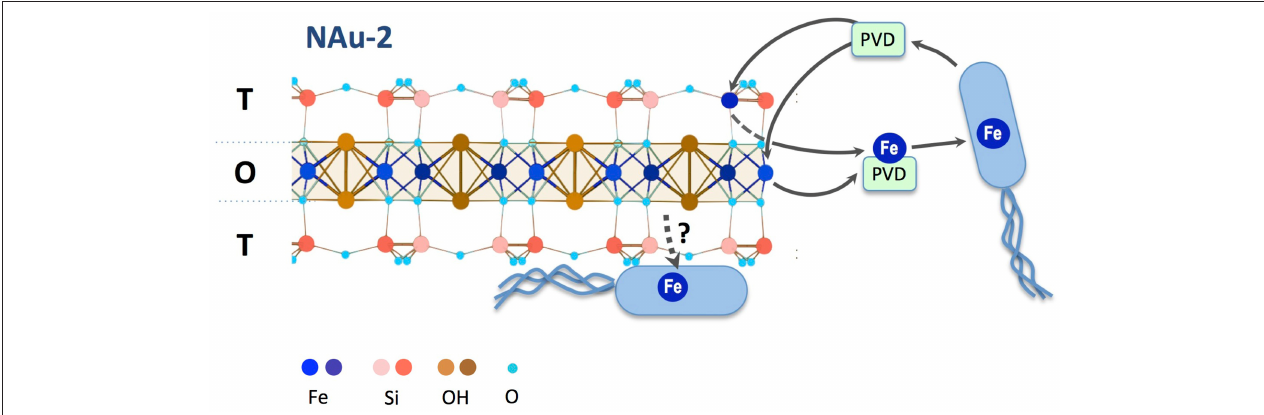
FIGURE 7 | Proposed mechanism of iron mobilization from nontronite. Under iron deficient conditions, P. aeruginosa produces pyoverdine that chelates and solubilizes Fe(III) from edge sites of octahedral (O) or tetrahedral (T) sheets. The higher occurrence of tetrahedral Fe(III) sites in NAu-2 facilitates iron mobilization compared to NAu-1. Iron from pyoverdine-Fe 3 + complexes can be taken up into the bacterial cell to sustain growth. When in direct contact with the mineral particles, P. aeruginosa can acquire iron via a siderophore-independent